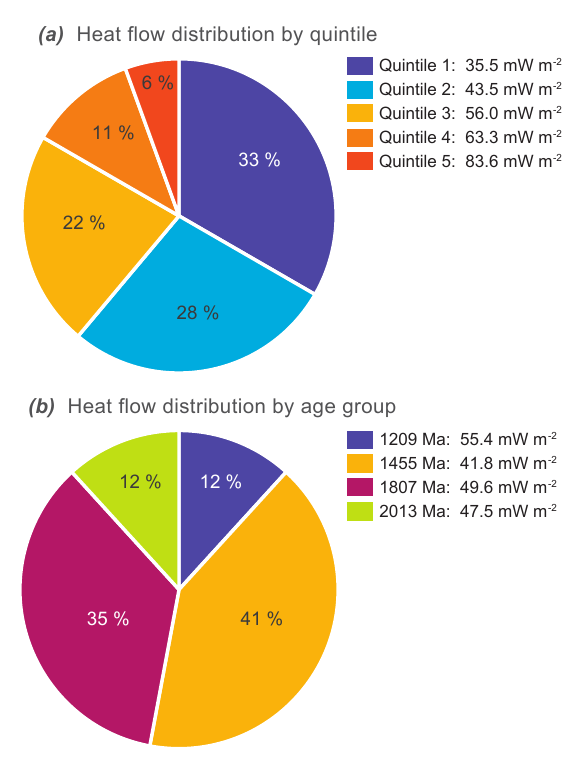
Figure 6. Pie charts summarizing distribution of heat flow estimates in this study. (a) Distribution of heat flow by quintiles between 30 and 80mWm − 2 . Quintile averages are shown with the high- est quintile represented by one sample with calculated heat flow of about 84mWm − 2 . (b) Distribution of average heat flow by age groups. Values are shown in Table